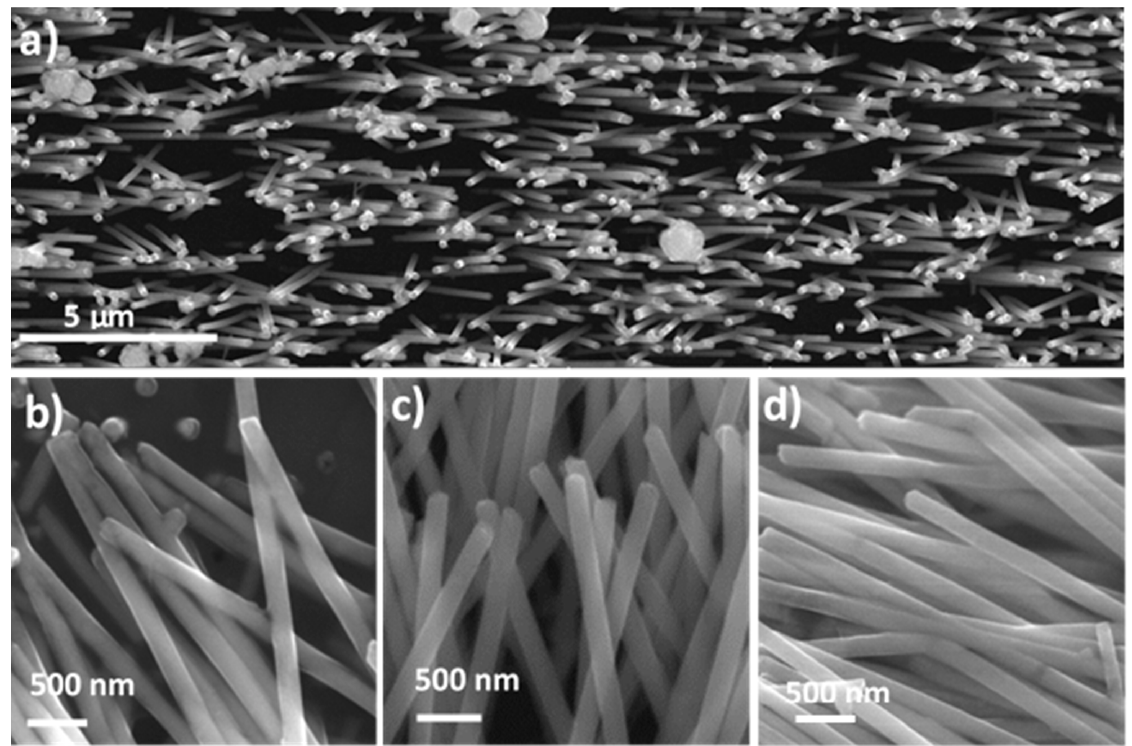
Figure 6. Scanning electron microscopy images of the Fe nanowires observed after membrane dissolution and measured for the nanowires that were deposited at the different electrolyte temperatures: 15 ◦ C ( b ), 25 ◦ C ( a , c ), and 40 ◦ C ( d ).